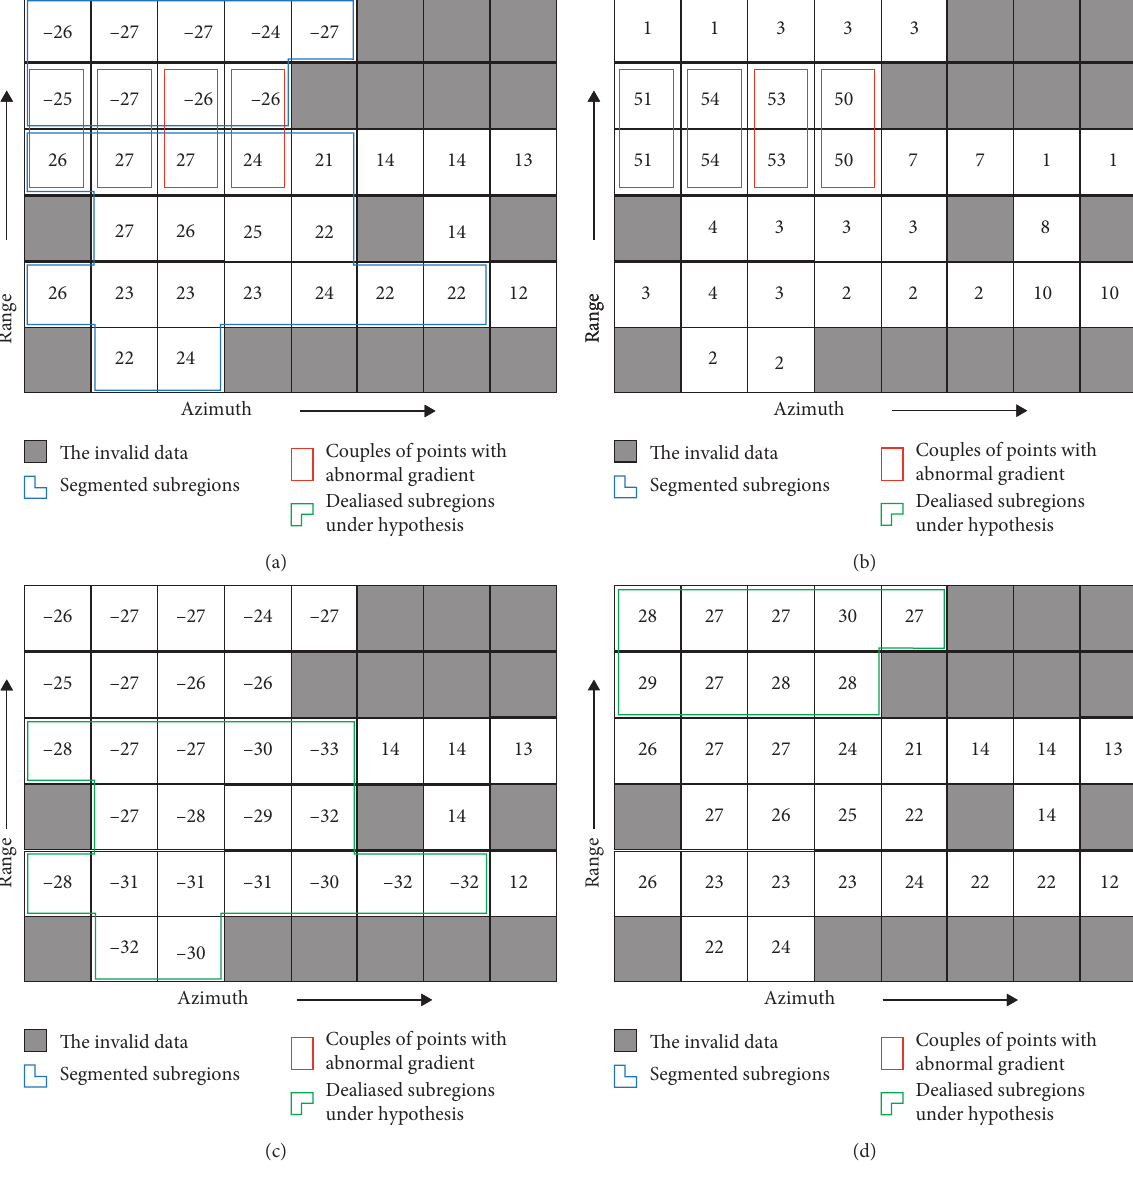
Figure 4: The behavior of the dealiasing in a region illustrated within a hypothetical azimuth-range sector: (a) the raw velocity, (b) the gradient corresponding to the raw velocity, (c) the dealiased velocity under Hypothesis 1, (d) the dealiased velocity under Hypothesis 2. Gray points indicate invalid data. Blue polygons in (a) mark the segmented subregions. Red rectangles in (a) and (b) denote the couples of points with abnormal gradient. Green polygons in (c) and (d) mark the dealiased subregions under different hypothesizes,